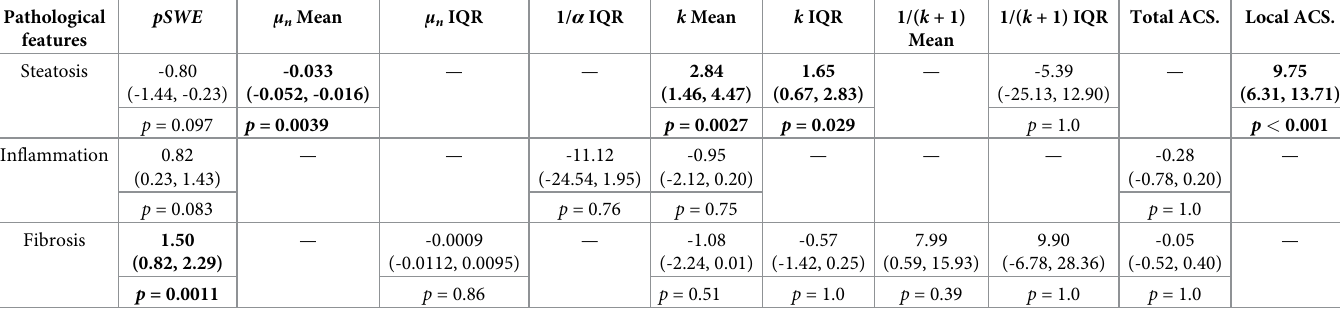
Table 3. Coefficients (with 95% confidence intervals in parentheses) of ordinal logistic regressions with the steatosis grade, or the inflammation grade, or the fibro- sis stage as responses, and with features appearing in Table 1, as single predictors. Pathological